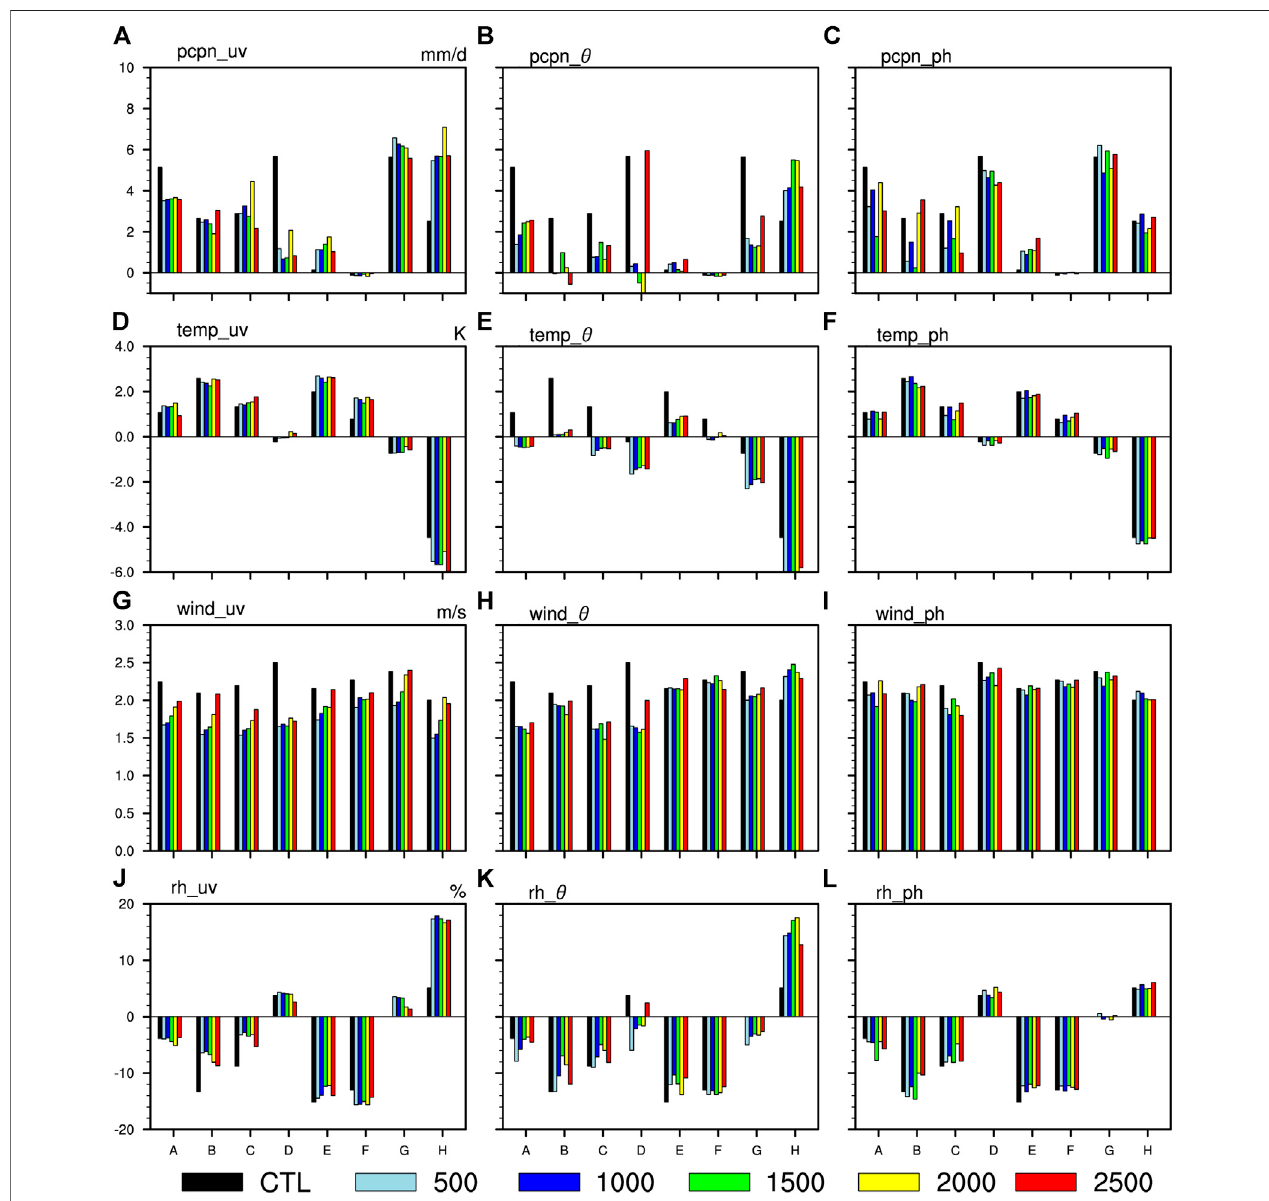
FIGURE4| Meanerror(ME)ofsimulatedsurfacemeteorological fi eldsunderdifferentcutoffwavelengths: (A – C) simulatedprecipitationwithnudginguv, θ ,andph, respectively; (D – F) 2 m temperature; (G – I) 10 m wind speed; (J – L) 2 m relative humidity.